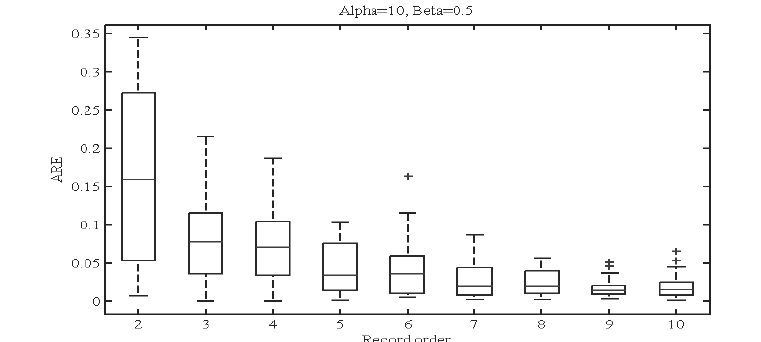
Figure 7 – Boxplot for ARE of ˆ (cid:68) .